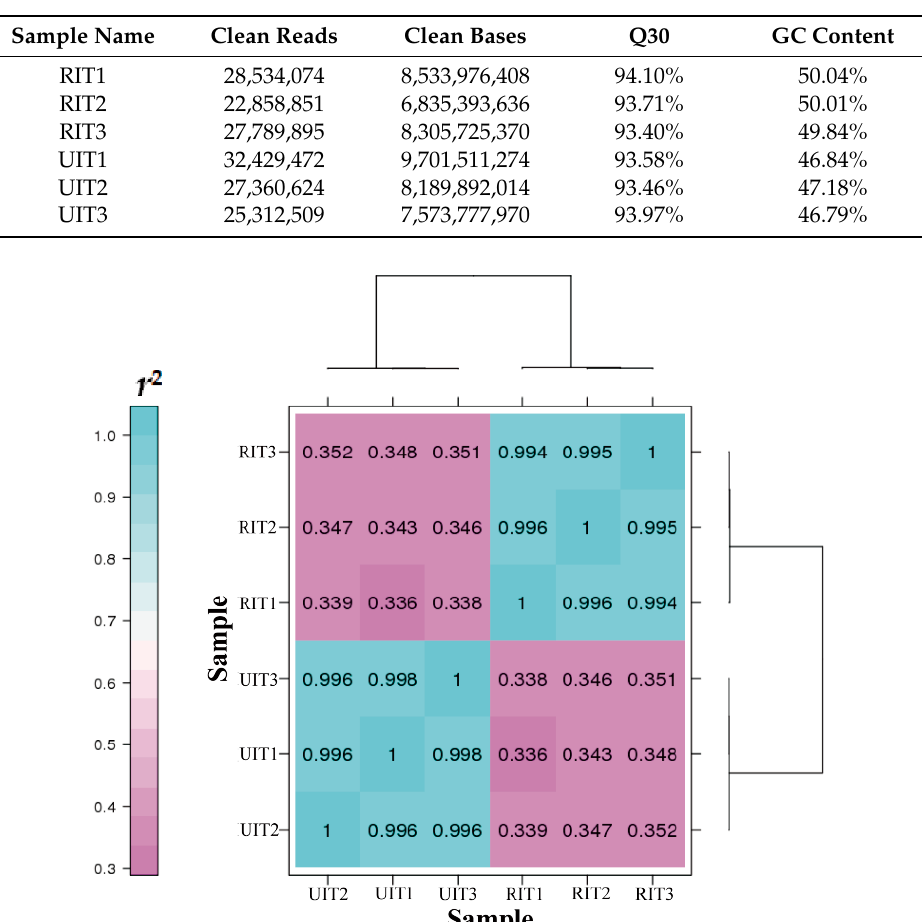
Figure 2. Correlation heat map of the gene expression quantity among biological replicates of the UIT and RIT samples ( n = 3).